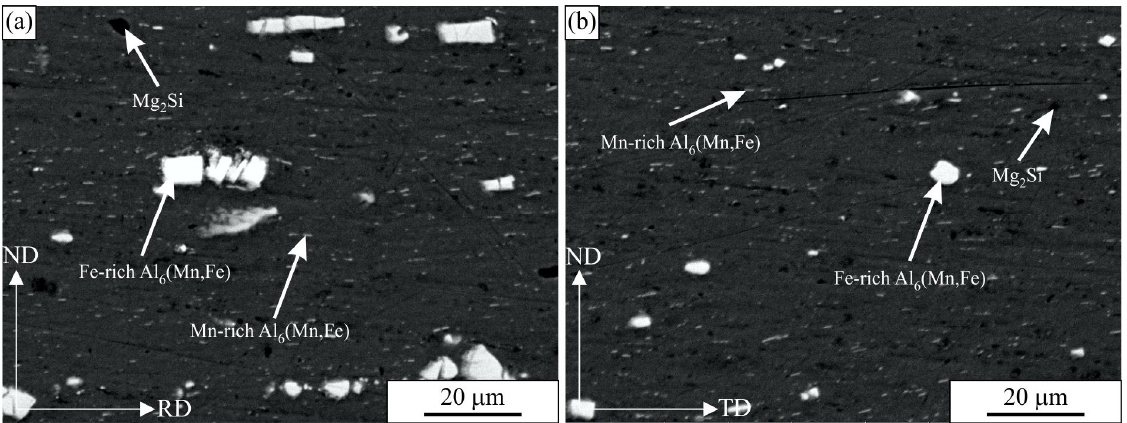
Figure 3. The backscattered electron images of the AA 5083-H111 alloy. ( a ) In the longitudinal direction. ( b ) In the transverse direction: RD-rolling direction, ND-normal direction, TD-transverse direction.